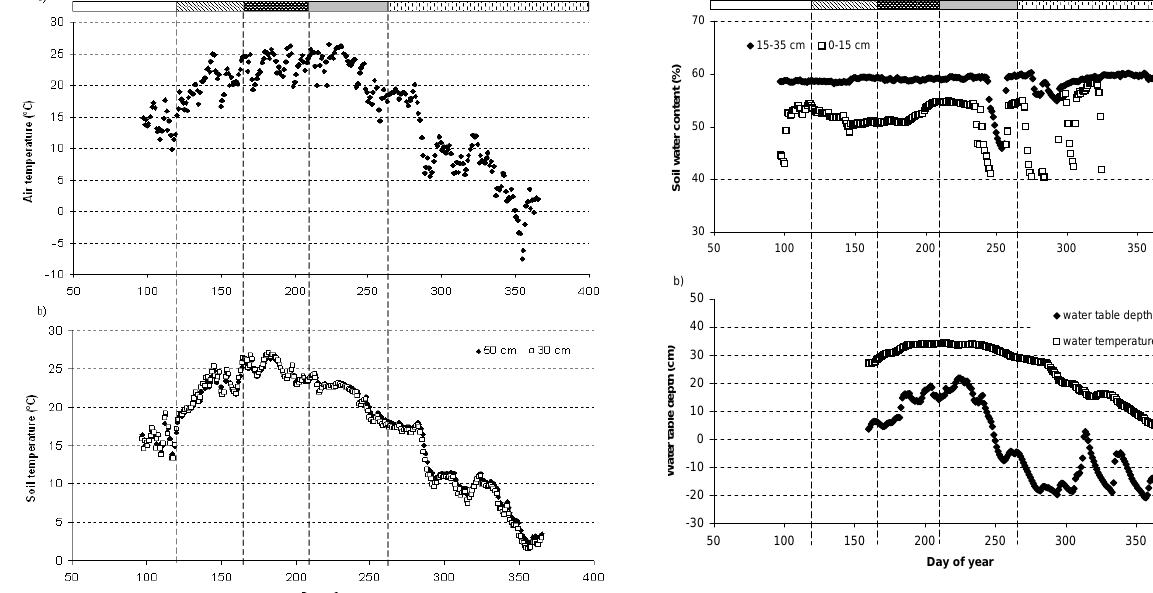
Fig. 1. Seasonal trends of the daily average air (a) and soil (b) temperatures at depths of 50 and 30cm.